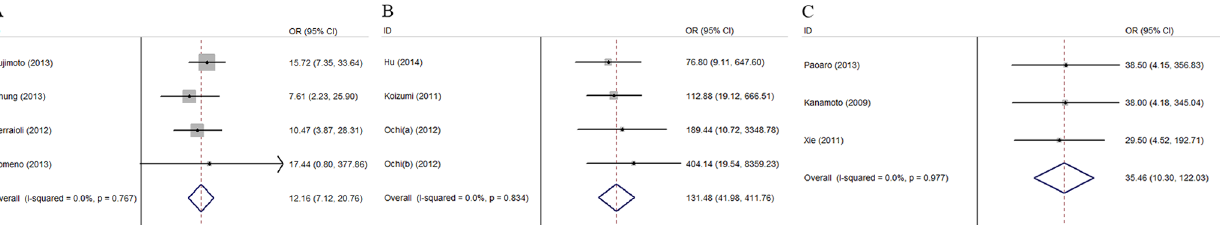
Fig. 4. Forest plot from meta-analysis of DOR value using a random-effect or fixed-effect model for significant fibrosis. (A) Forest plot of LFI and (B) Forest plot of ER1 and (C) Forest plot of ER2. DOR: diagnostic odds ratio; LFI: liver fibrosis index; ER1: the elastic ratio of the liver for the intrahepatic vein; ER2: the elastic ratio of the liver for the intercostal muscle; Ochi (a): the training set of the subjects in the study by Ochi et al; Ochi (b): the validating set of the subjects in the study by Ochi et al.